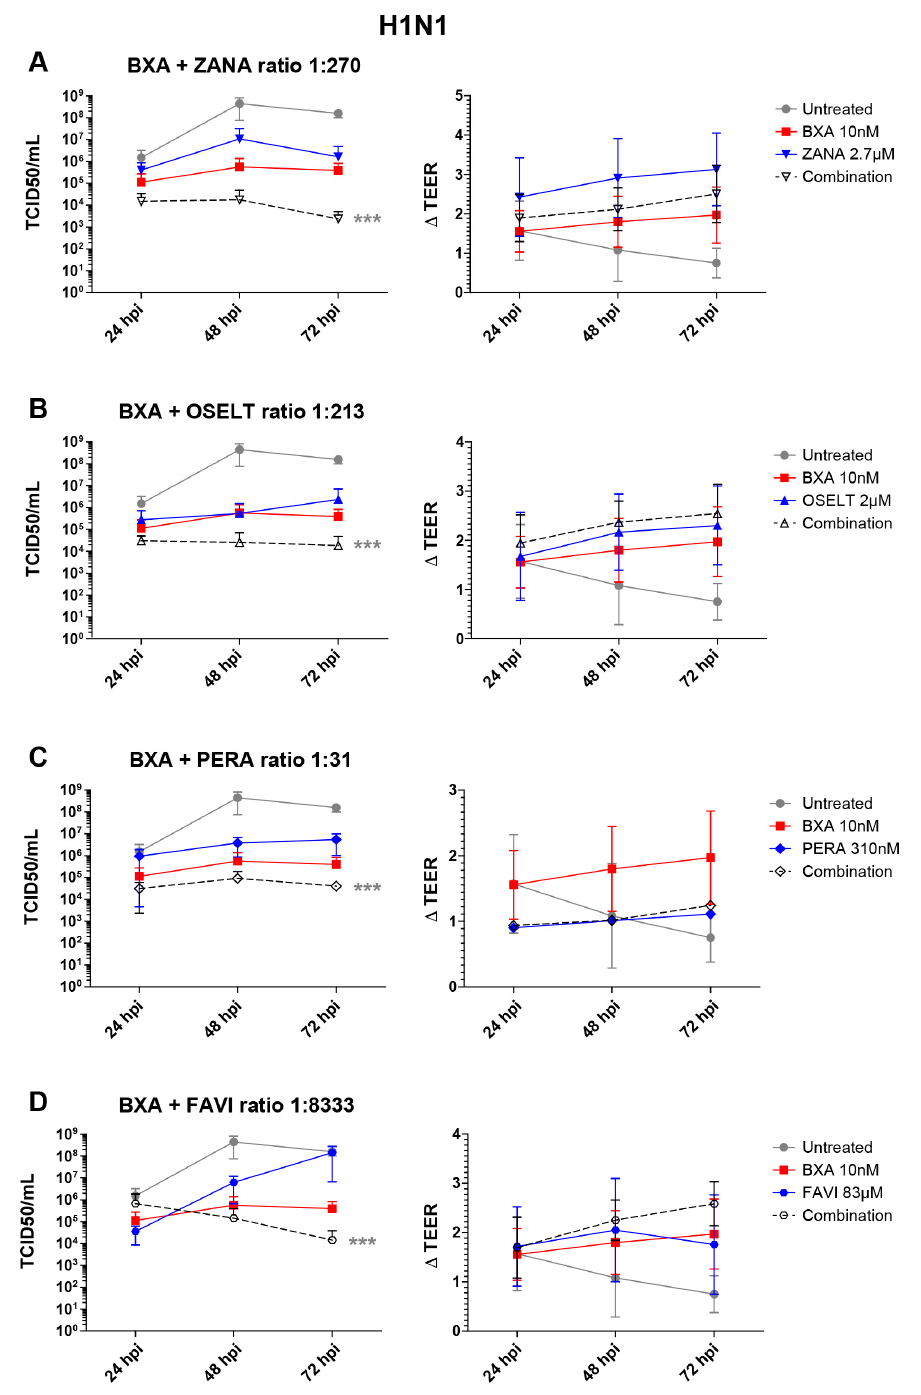
Figure 1. Two-drug combination activity in influenza A(H1N1)-infected reconstituted human airway epithelia (HAE). Apical viral production (TCID50 / mL ± standard deviation, SD) and transepithelial electrical resistance ( ∆ TEER (transepithelial electrical resistance) vs. t = 0 ± SD) in MucilAirTM HAE infected on the apical pole with influenza A / California / 7 / 2009 (H1N1) virus at a multiplicity of infection (MOI) of 0.1 and treated with the indicated antiviral combinations and their corresponding single drug controls by the basolateral pole: ( A ) baloxavir acid + zanamivir; ( B ) baloxavir acid + oseltamivir; ( C ) baloxavir acid + peramivir; ( D ) baloxavir acid + favipiravir. *** p < 0.001 compared to the infected untreated group using mixed model two-way analysis of variance (ANOVA) with Bonferroni post hoc test. Data are representative of at least four independent